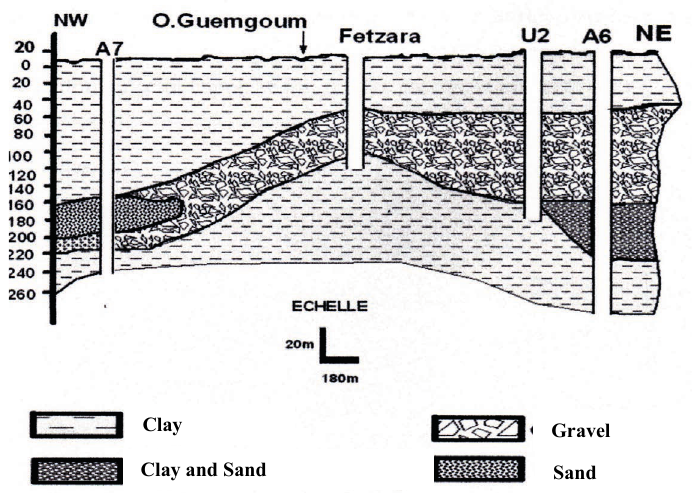
Fig. 3 Hydrogeology cross-section of Tarf area (Aoun Sebaiti Badra 2010).